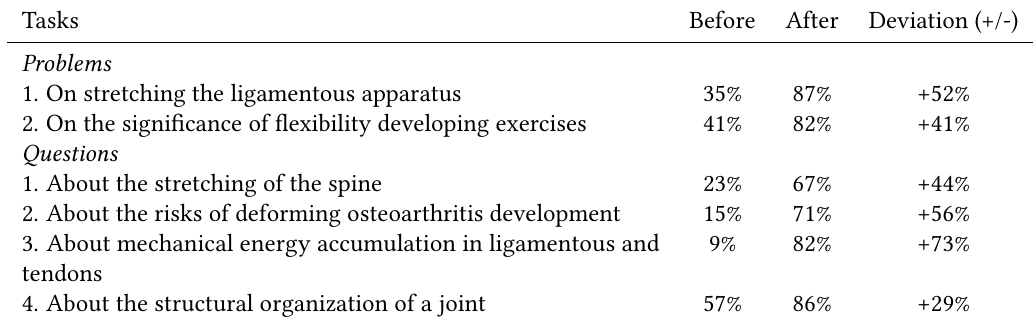
Table 1 The data received before and after the implementation of the methodology with the use of the “Virtual Model of Identifying the Risks for Locomotor Apparatus Caused by Ligament Stretching” software app. Tasks Before After Deviation